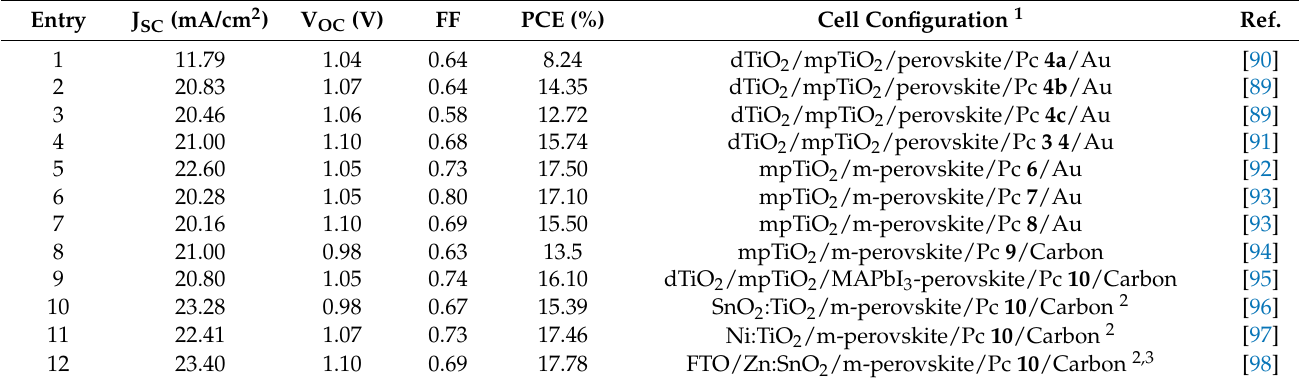
Table 1. Photovoltaic parameters obtained for perovskite solar cells employing phthalocyanines as hole-transporting materials.